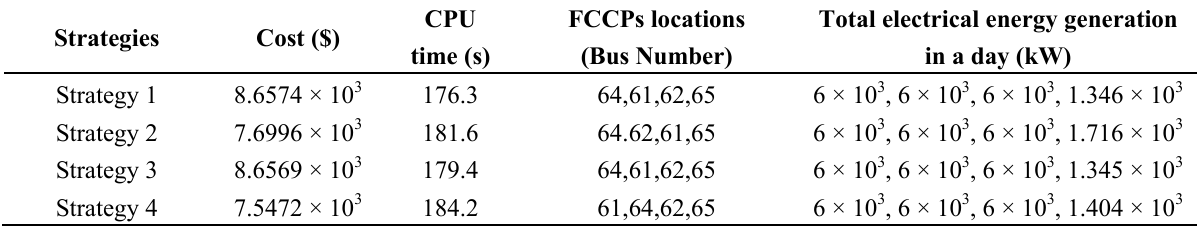
Table 4. Results obtained by optimizing the Cost.